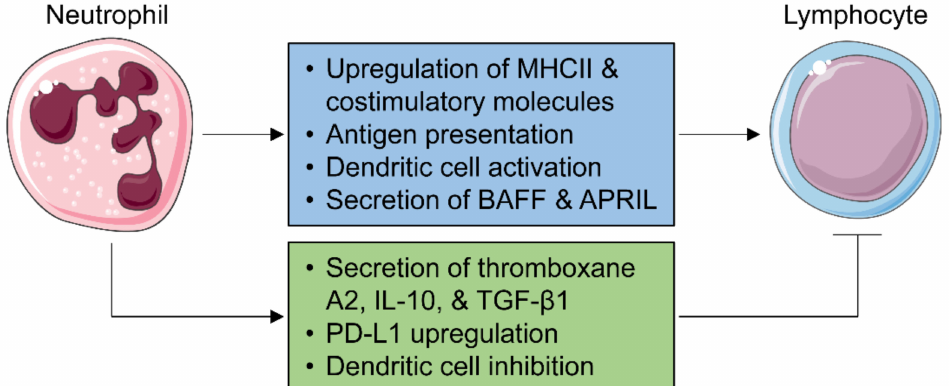
Figure 3. Neutrophil regulation of adaptive immunity. Following infection or inflammation, cir- culating neutrophils are recruited to lymph nodes, where they modulate the adaptive immune response. On the one hand, neutrophils are able to activate T cells and induce T cell proliferation and cytokine generation by upregulating major histocompatibility complex II (MHCII) and costimulatory molecules, presenting antigens, as well as activating dendritic cells. They also modulate B cell activation and survival by secreting B cell-activating factor (BAFF) and a proliferation-inducing ligand (APRIL). On the other hand, neutrophils can dampen adaptive immunity to prevent its over- activation by generating thromboxane A2, interleukin (IL)-10, transforming growth factor (TGF)- β 1, upregulating programmed death ligand 1 (PD-L1), and inhibiting dendritic cell functions. Images of cells are from Servier Medical ART (Accessed date 1 June 2021